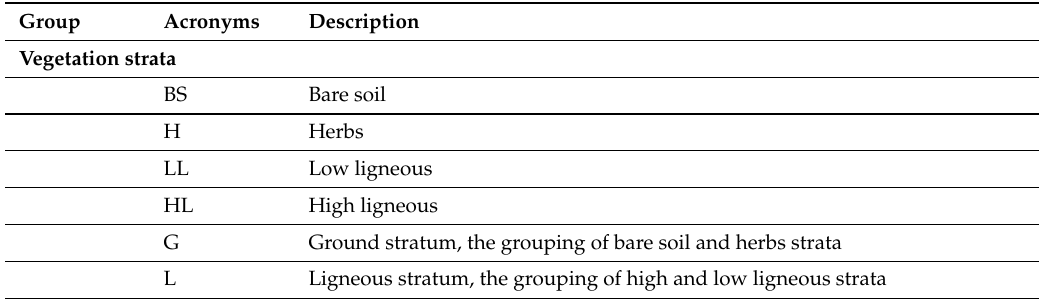
Figure 2. Representation of the methodological framework used to study the influence of radiometry, spatial resolution and fusion on the characterization of vegetation structure with combined textural and radiometric indices with ( a ) the comparison of the estimation of landscape metric; the variation of ( b ) radiometric and ( c ) textural indices and ( d ) the comparison of the spatial representation of the vegetation structure with RGB maps representation. Table 3. List of the acronyms used in the